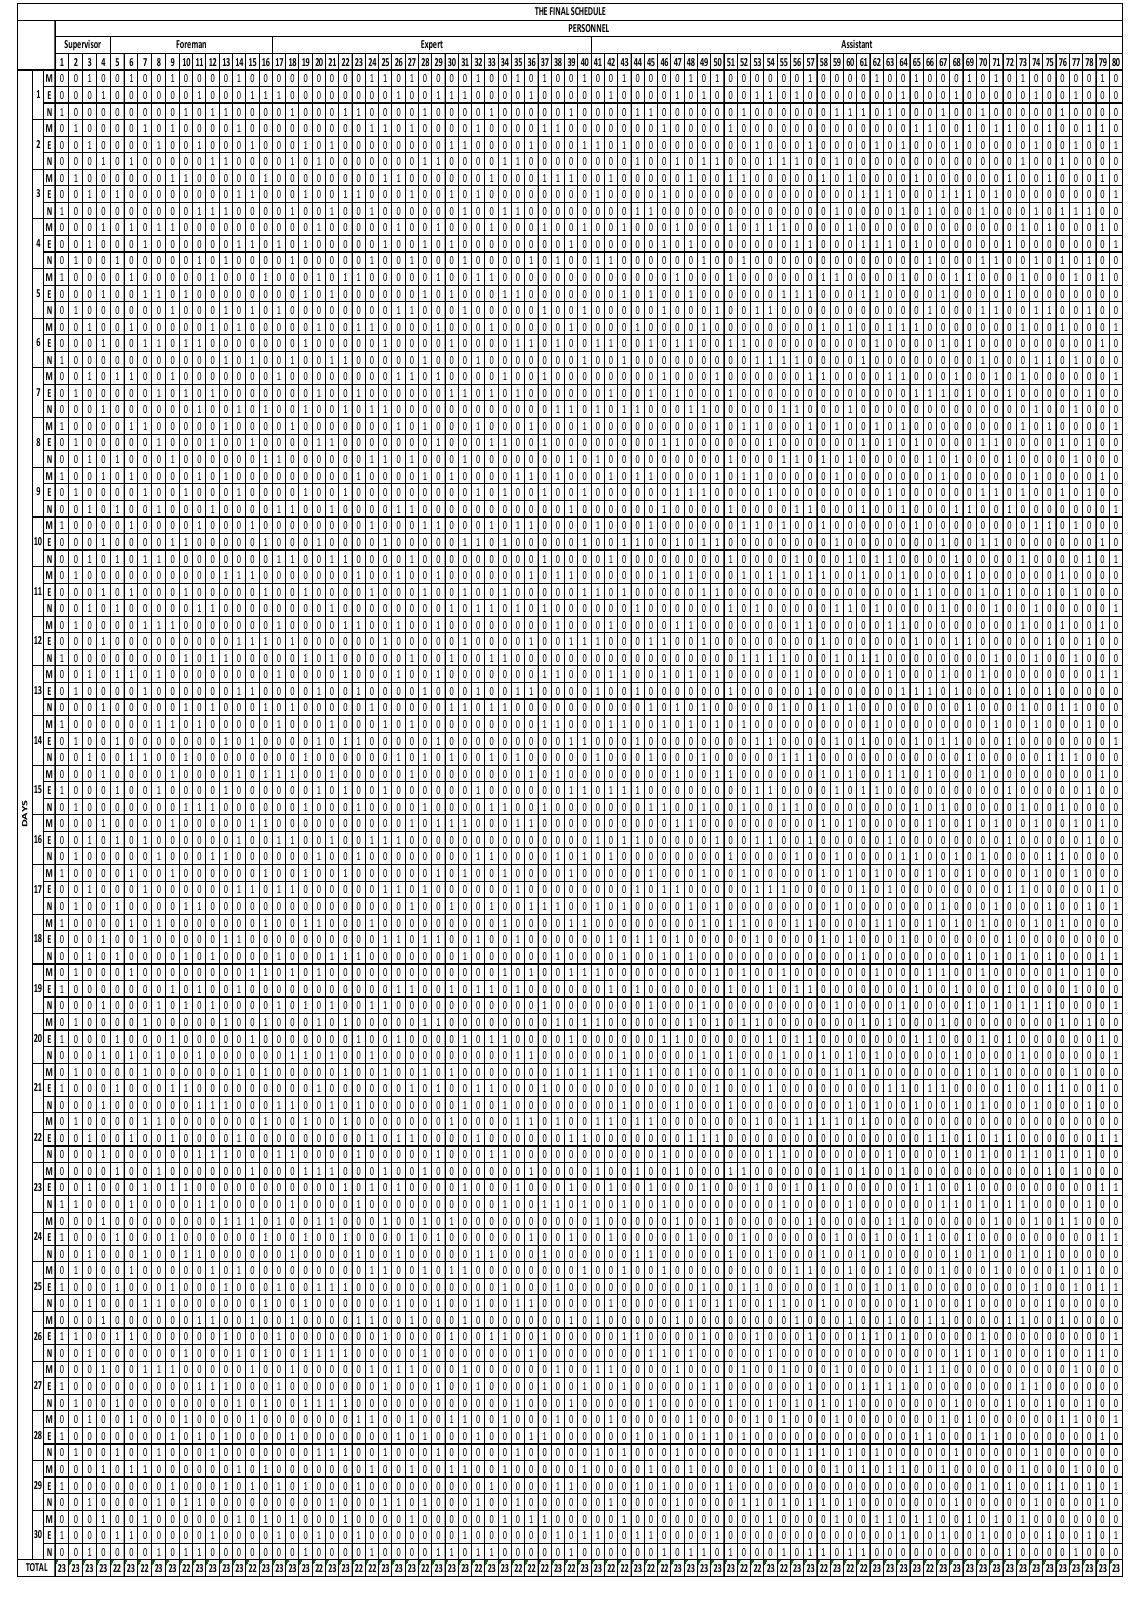
Figure 6. The final schedule